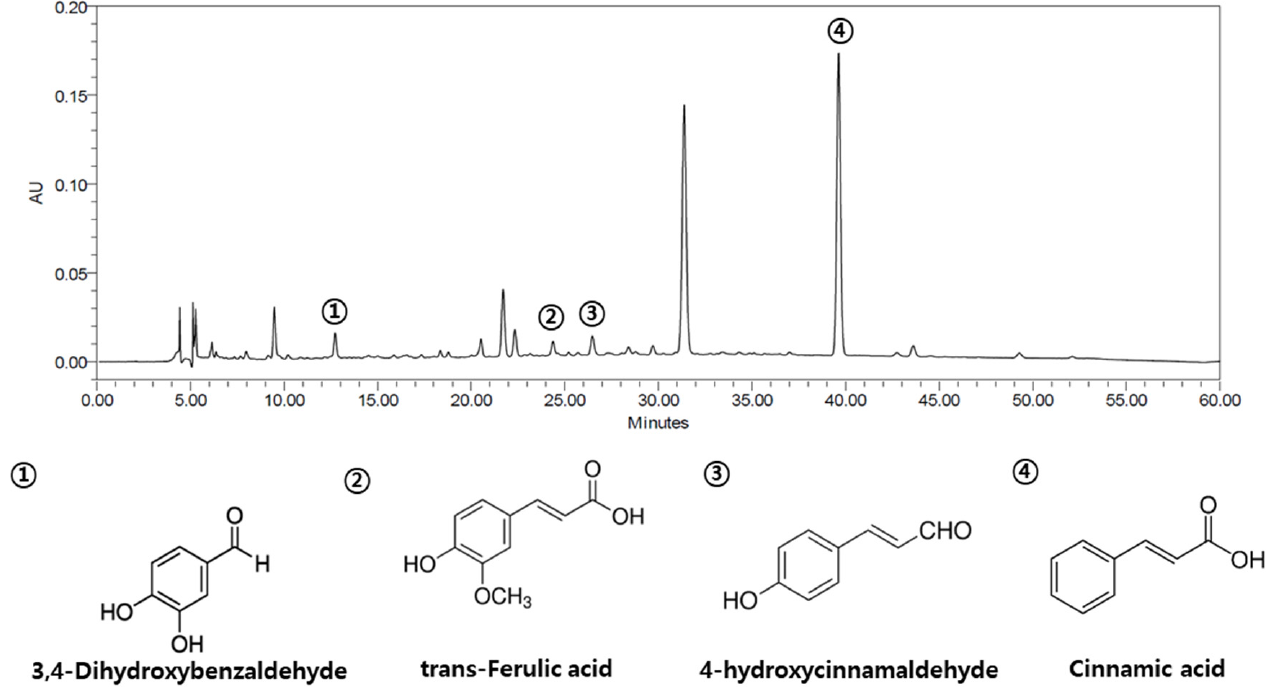
Figure 1. HPLC chromatogram of ECC. ECC was analyzed using Alliance HPLC (Waters e2695, MA, USA) and was used for cell and animal tests. Standardized extract of Cinnamomum cassia (ECC).